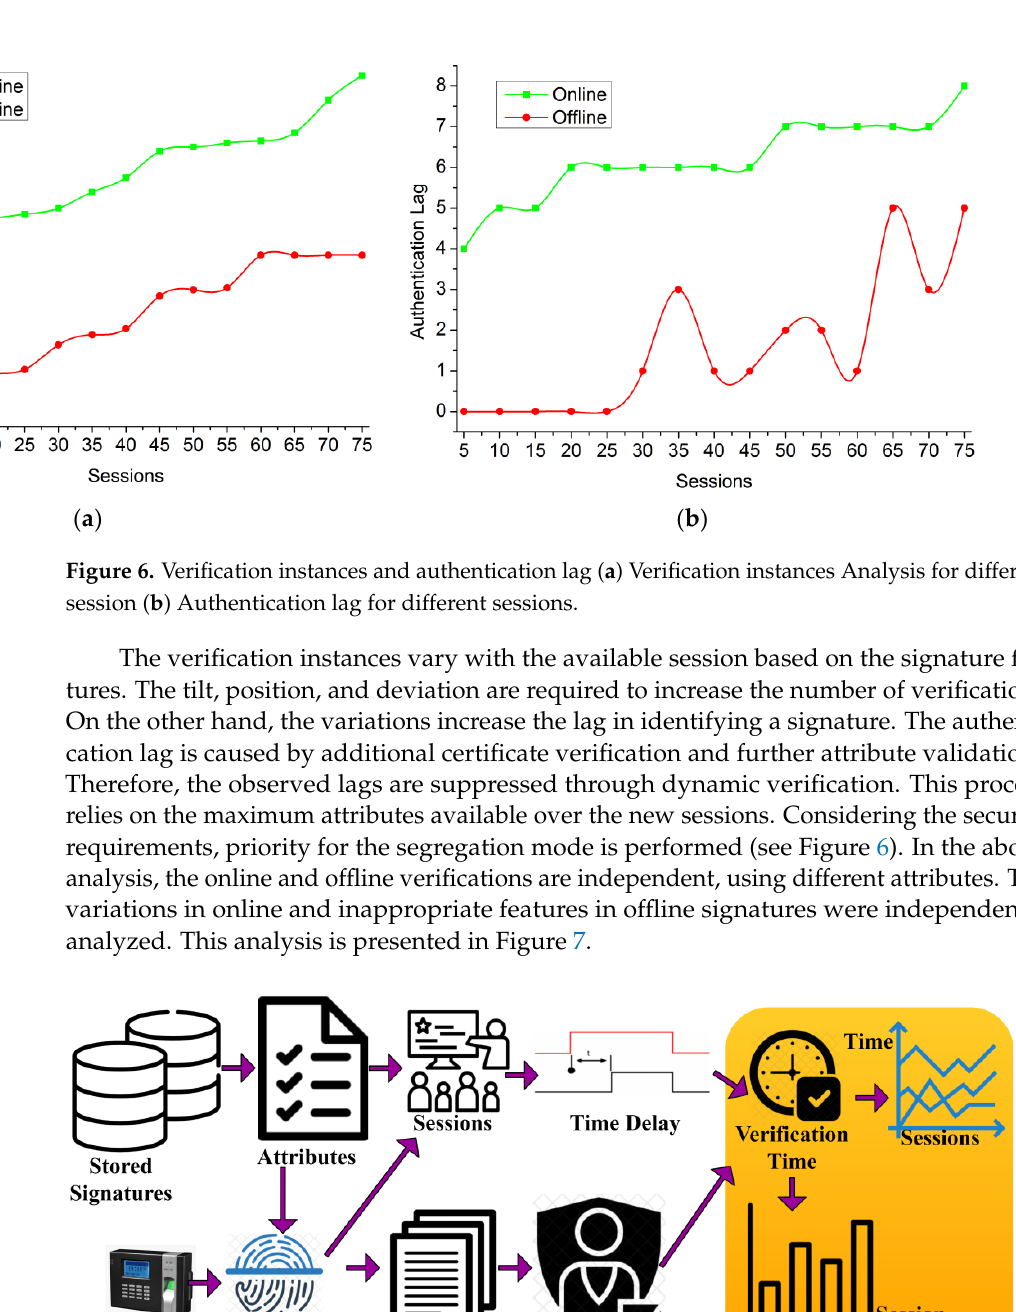
( b ) Figure 8. Mutual Time Analysis for ( a ) Different time interval ( b ) Various key. The mutual time for authentication and verification is high for an online process compared to that for an offline process. Considering the advantages of stored sign veri- fications, the documents/existing features require less time. The online validation relies on the 𝑆𝑍 and 𝐾𝑦 𝑡 for secure verification and for preventing failures. Therefore, the failures/sessions identify the need for implementing authentication across different pro- cesses. In the concurrent processing and verification instances, the digital certificates hold for verifying offline assessments. The assessments are increased based on the 𝑆𝑍 classifications shown in Figure 9.